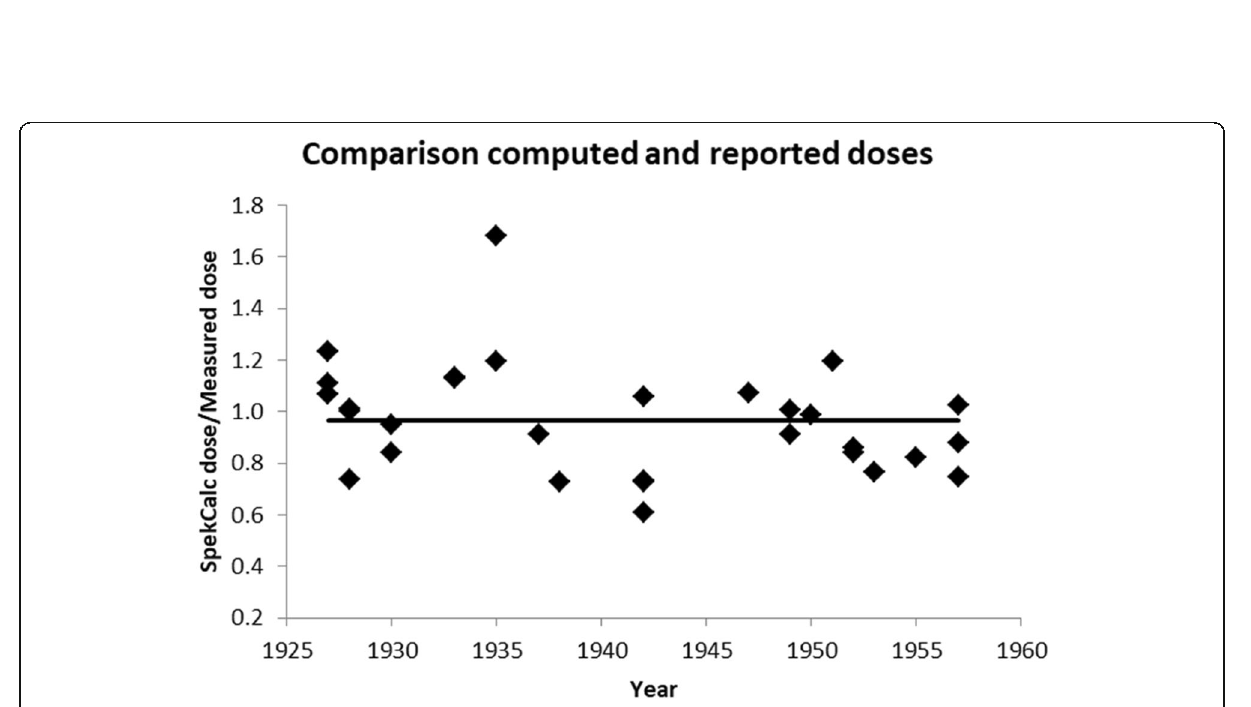
Fig. 6 Ratio of dose according to our computational approach and reported measured dose ( n =